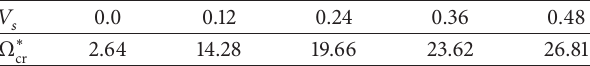
Table 5: The critical rotating speed corresponding to the different SMA wire fractions ( 𝑇 = 50 ∘ C, 𝜀 0 = 0.067 ).